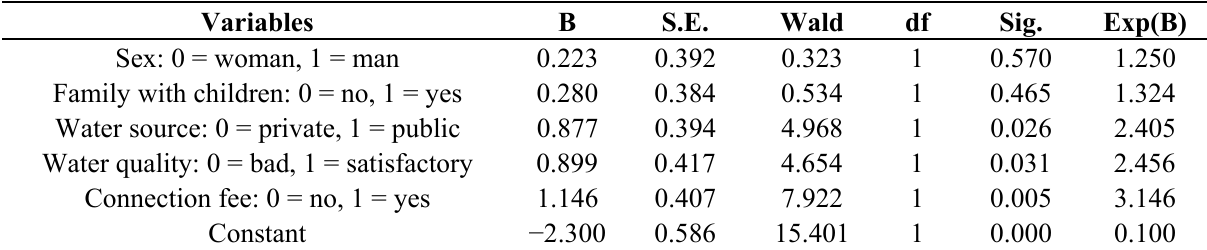
Table 4. Explanatory variables of WTP for standpipe water.